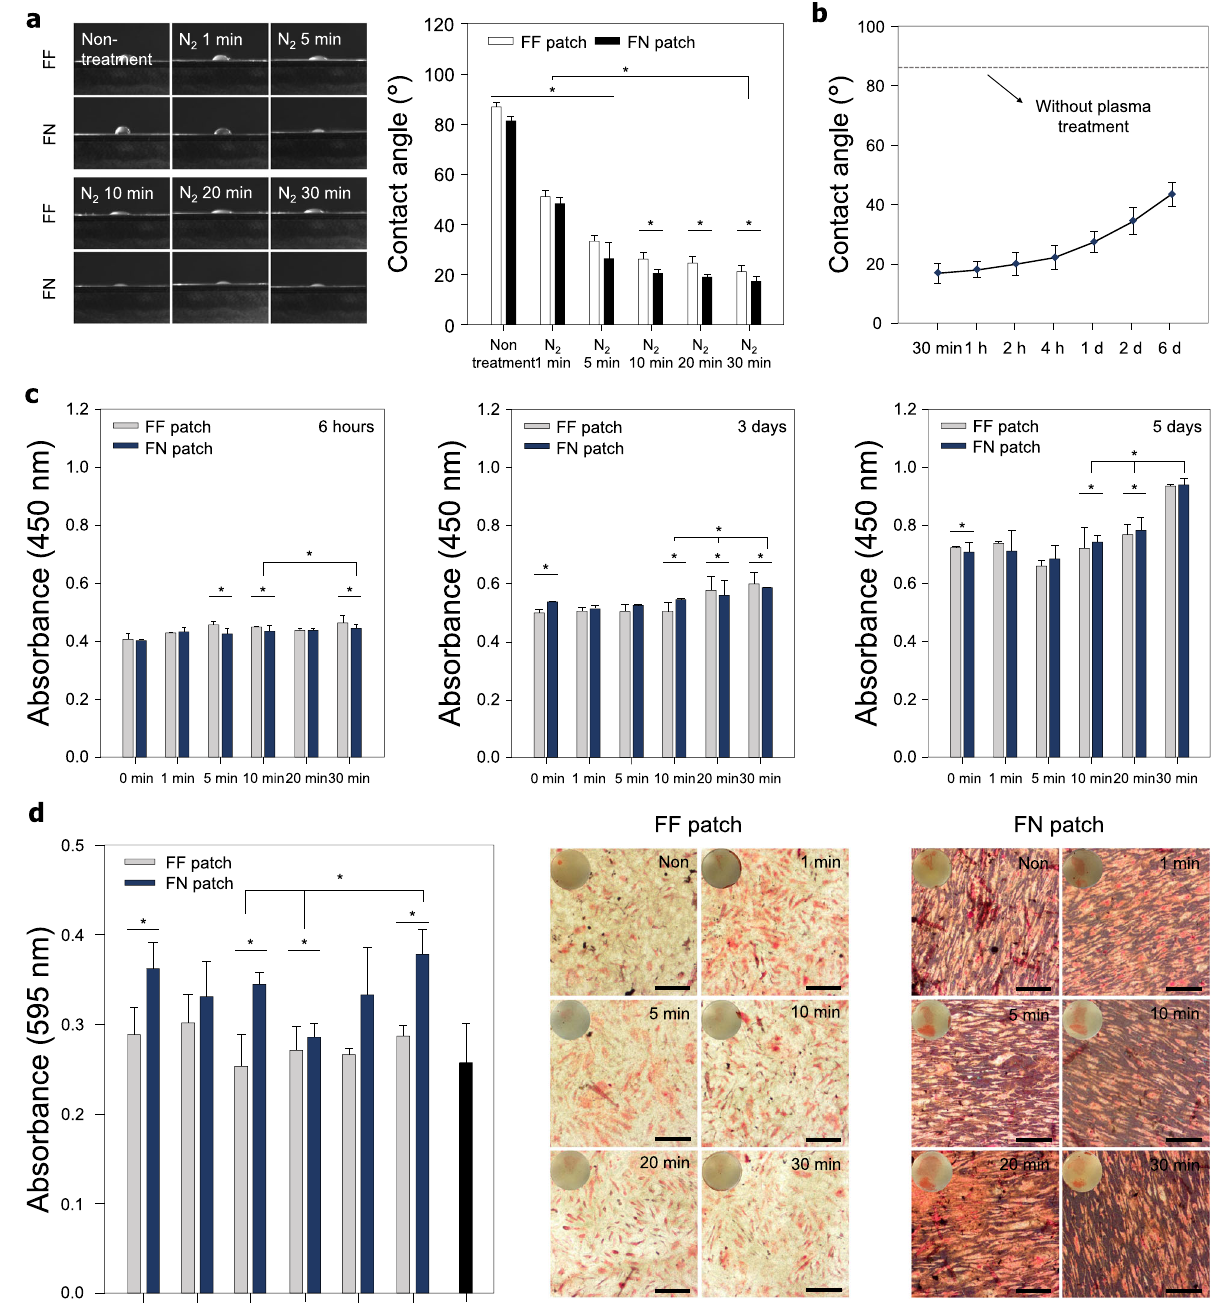
Fig. 2 Effect of N-FN patches on cellular behaviors. a Water contact angle measurement of the N-FN treated under various times ( n = 10 for each group). b Wettability recovery on the surfaces of 30-min N-FN patches ( n = 5). c Attachment and proliferation of cells on N-FN patches. Quantitative analysis of cell attachment and proliferation on N-FF patches and N-FN patches showed a gradual increase with plasma treatment time ( n = 6 for each group). d Effect of N-FN patches on the osteogenic mineralization of tenocytes. Alizarin Red staining and quanti fi cation of the degree of osteogenesis showed that the 30-min N-FN patch promoted higher calcium expression levels of tenocytes when compared with other groups ( n = 6 for each group). Scale bars = 200 µm. Error bars = mean ± standard deviation (* P < observed due to etching and volatilization, which were not generated in the N-FN patches. The O-FMN patches showed the Figure 3a shows a schematic of the plasma treatment process uniform distribution of various pore sizes and more pores, used in this study (described in detail in “ Methods ” ). SEM images depending on the O 2 plasma treatment time compared to the of the surface morphology of the O-FMN patches revealed a O-FF patches (Fig. 3b and Supplementary Fig. 1). The average pore highly aligned topography with grooves and ridges, similar to the sizes of 30 min O-FMN and 30 min O-FF patches were analyzed as well-organized topography of the tendon ECM (Fig. 3b). Nanosized 192.84 and 145.16 nm, respectively. These results are due to when pores generated by O 2 plasma treatment for 30 min were